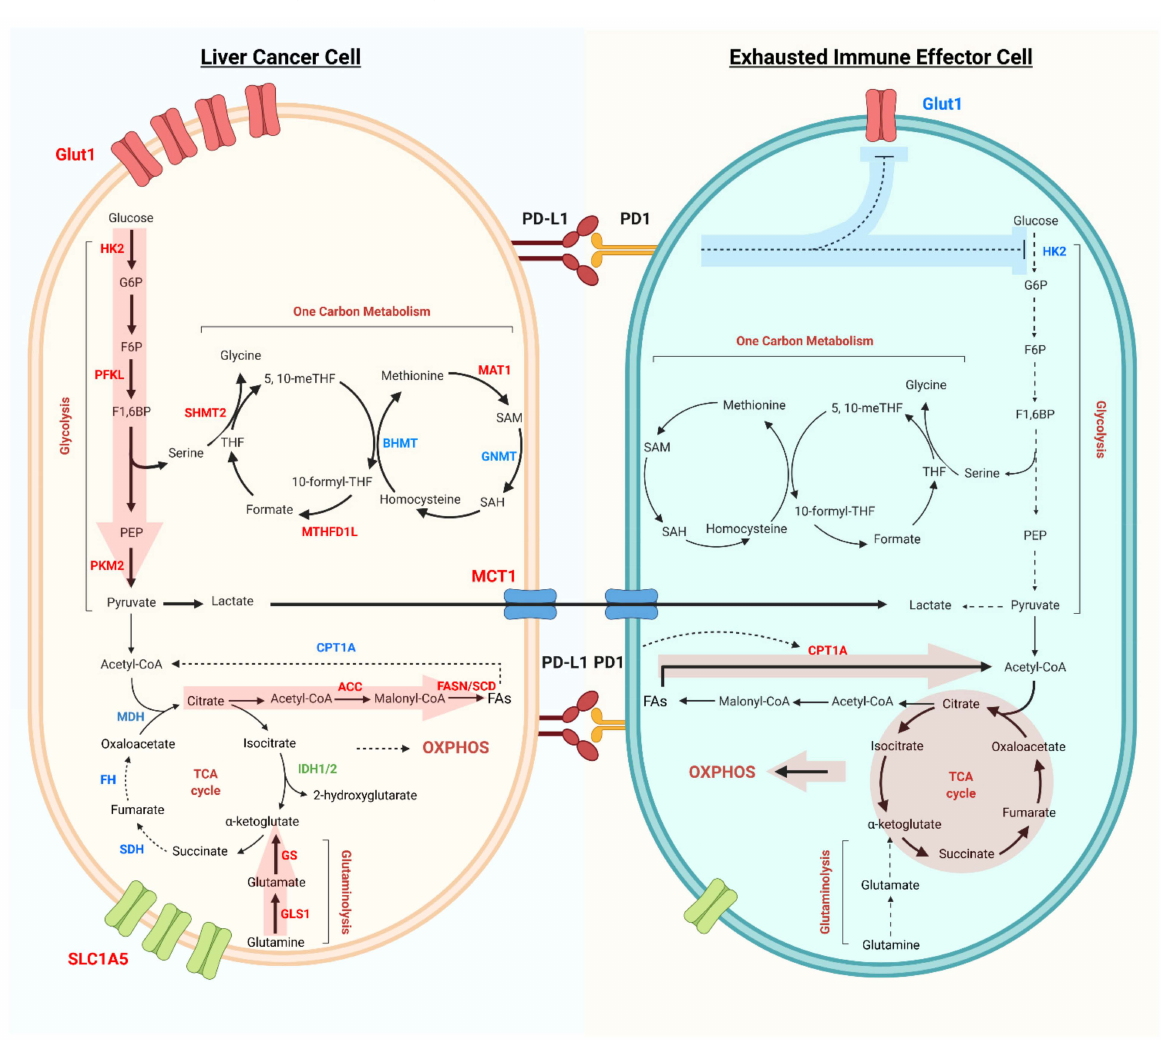
Figure 1. Metabolic reprogramming of liver cancer cells and exhausted immune effector cells in the tumor microenvironment. Liver cancer cells have increased glycolysis flux, as well as increased expression of Glut1, rate-limiting enzymes HK2, PFKL, and PKM2 (red). Glutaminolysis and fatty acids synthesis are the other two main pathways important for tumor cell survival and proliferation. While the TCA cycle and fatty acid oxidation, as well as the rate-limiting enzymes like SDH, FH, MDH, and CPT1A (blue) are downregulated in liver cancer cells. Metabolites, such as lactate, can be exported and influence the tumor infiltrated immune cells. In addition, tumor cell expressing PD-L1 can activate PD-1 on immune cells, inhibiting glucose uptake (Glut1) and Glycolysis (HK2). Dysregulated glycolysis, increased fatty acid oxidation and OXPHOS are the main metabolic phenotypes of exhausted immune effector